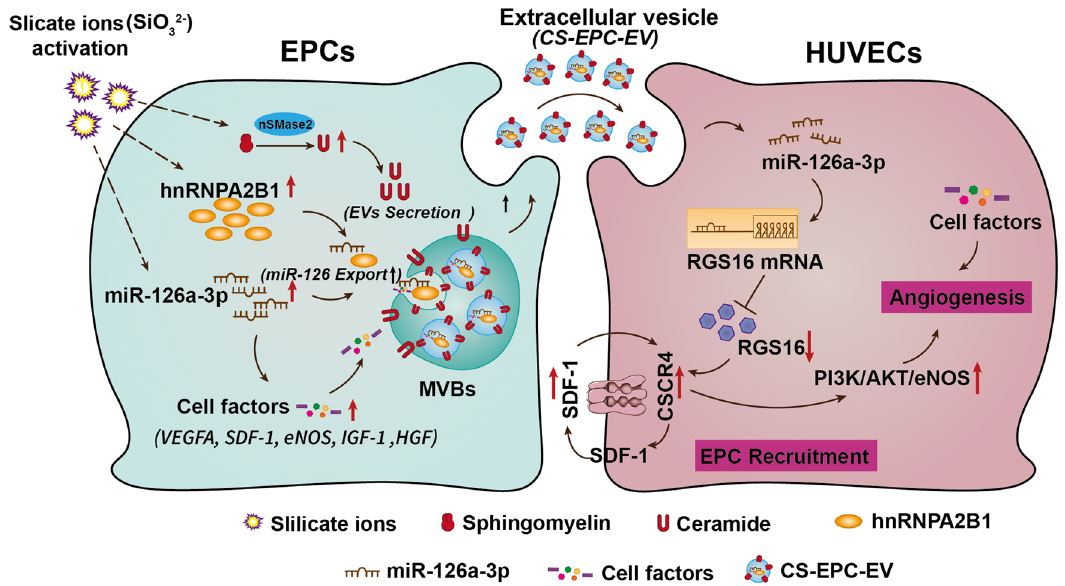
Fig. 10 | Summary of the mechanism underlying the stimulatory effect of CS- EPC-EVs on the recruitment of EPCs and angiogenesis of HUVECs. Silicate ions promote the expression of nSMase2, hnRNPA2B1 and miR-126a-3p in EPCs. The increased nSMase2 results in an increase in ceramide secretion in cells, thereby enhancing the production of extracellular vesicles. The higher hnRNPA2B1 and nSMase2levelsselectivelyenhanced thesorting of miR-126a-3pintomultivesicular bodies (MVBs, sites of extracellular vesicle biogenesis). In addition, the high expressionofmiR-126a-3ppromotestheexpressionofrelatedangiogenicfactorsin